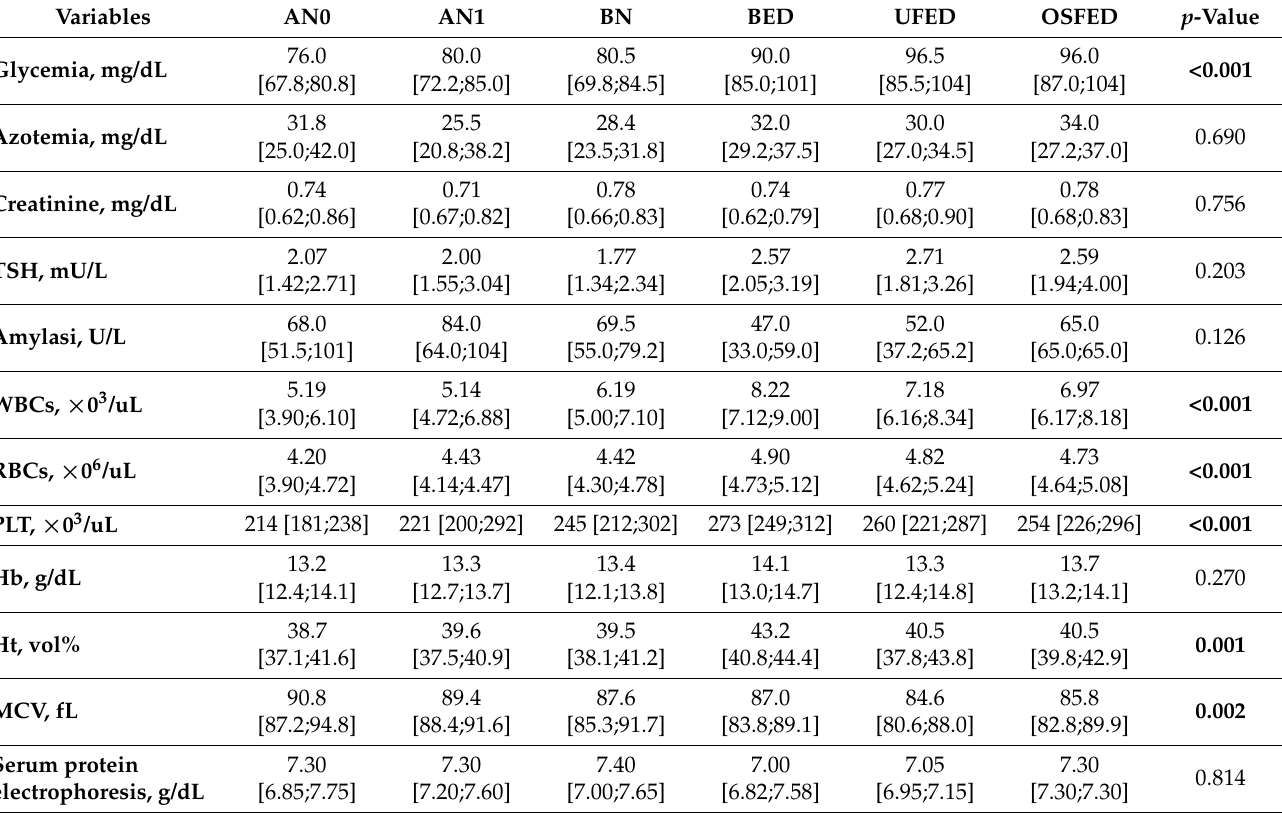
Table 3. Clinical data of ED groups. Summary descriptive table by groups of diagnosis for laboratory variables expressed as median (q1 = first quartile; q3 = third quartile). p -values are according to the Kruskal–Wallis test. Statistically significant values are in bold. TSH: thyroid-stimulating